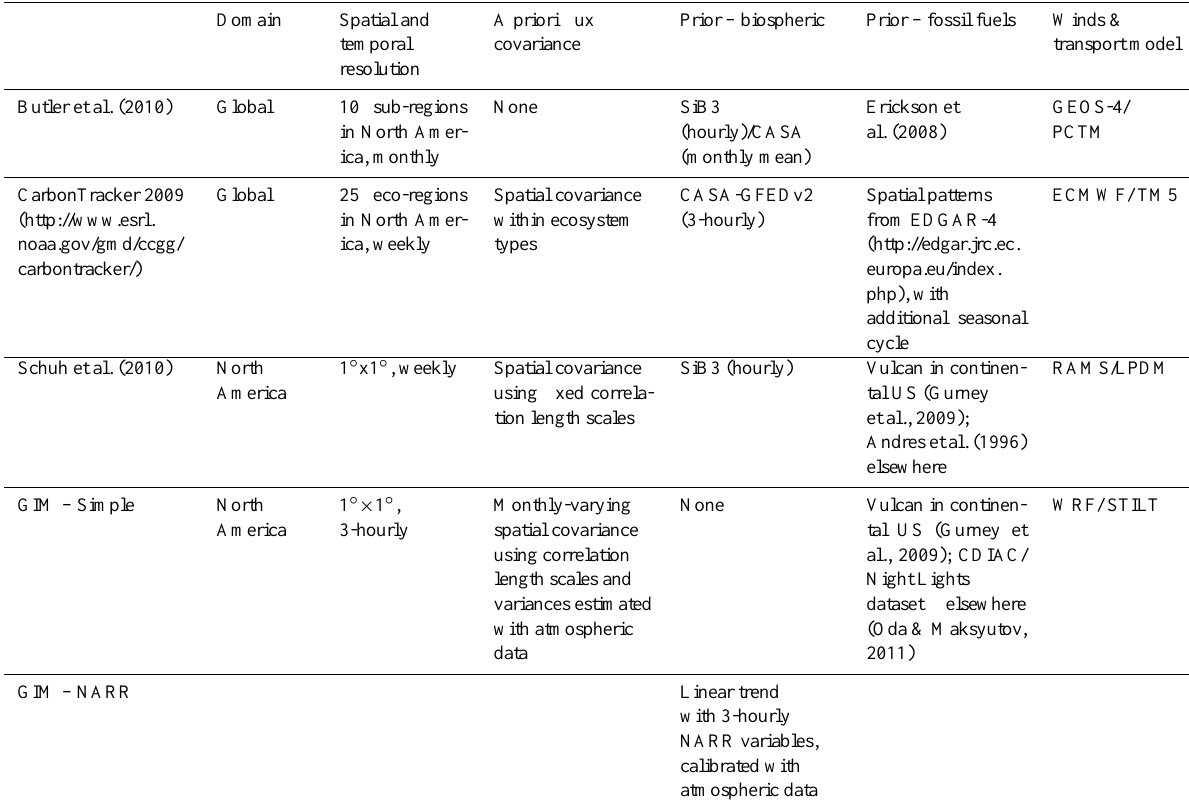
Table 1. Comparison of setup and input data across published inversion studies for North America in